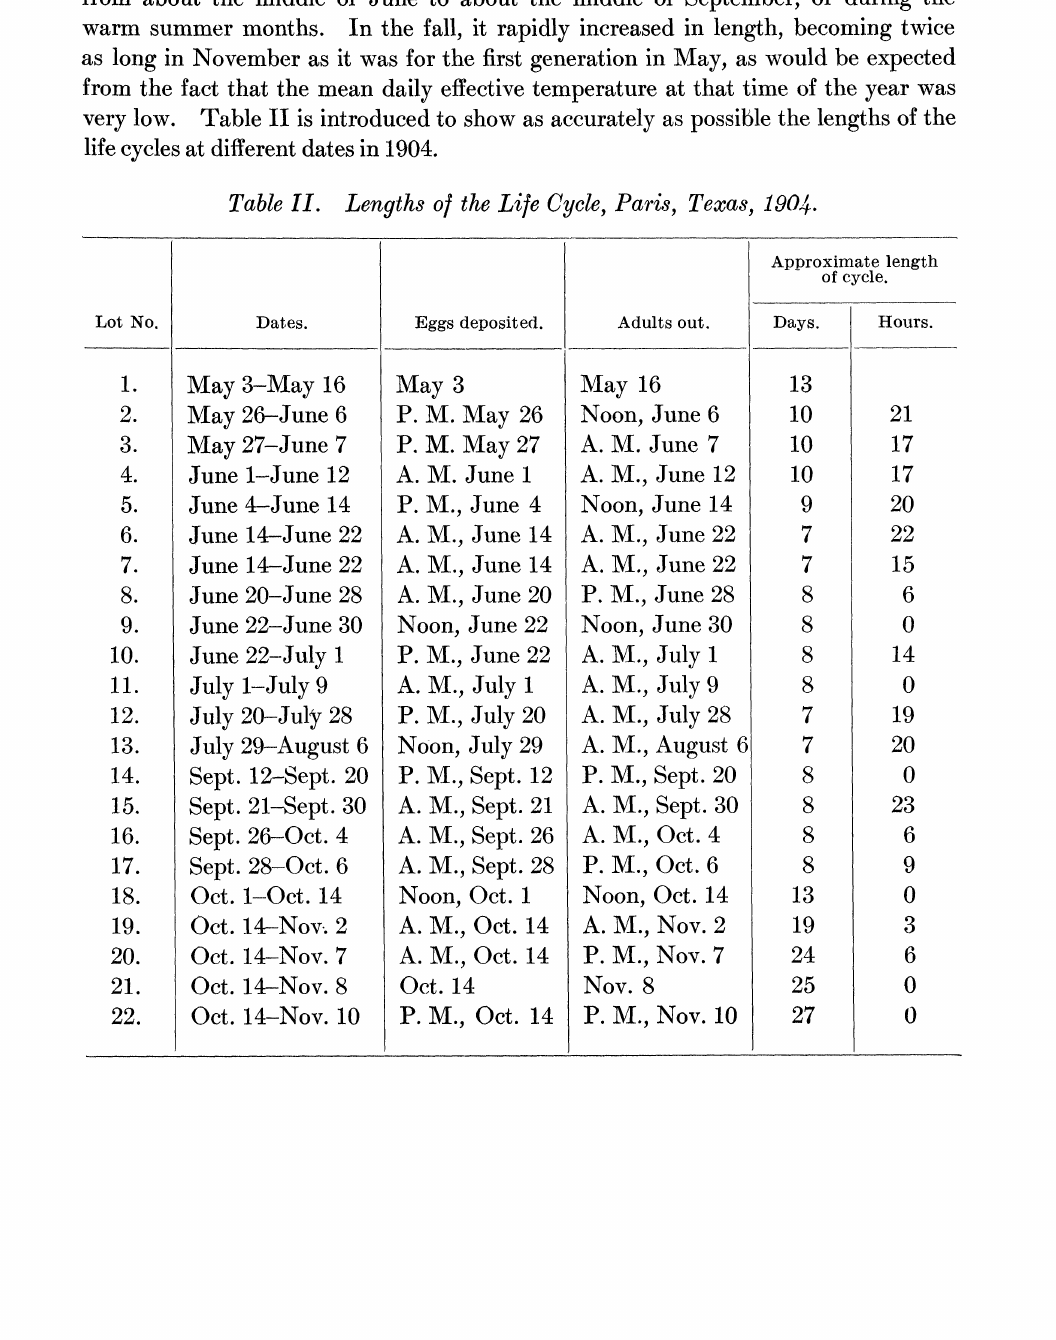
Table II. Lengths o] the Li]e Cycle, Paris, Texas,